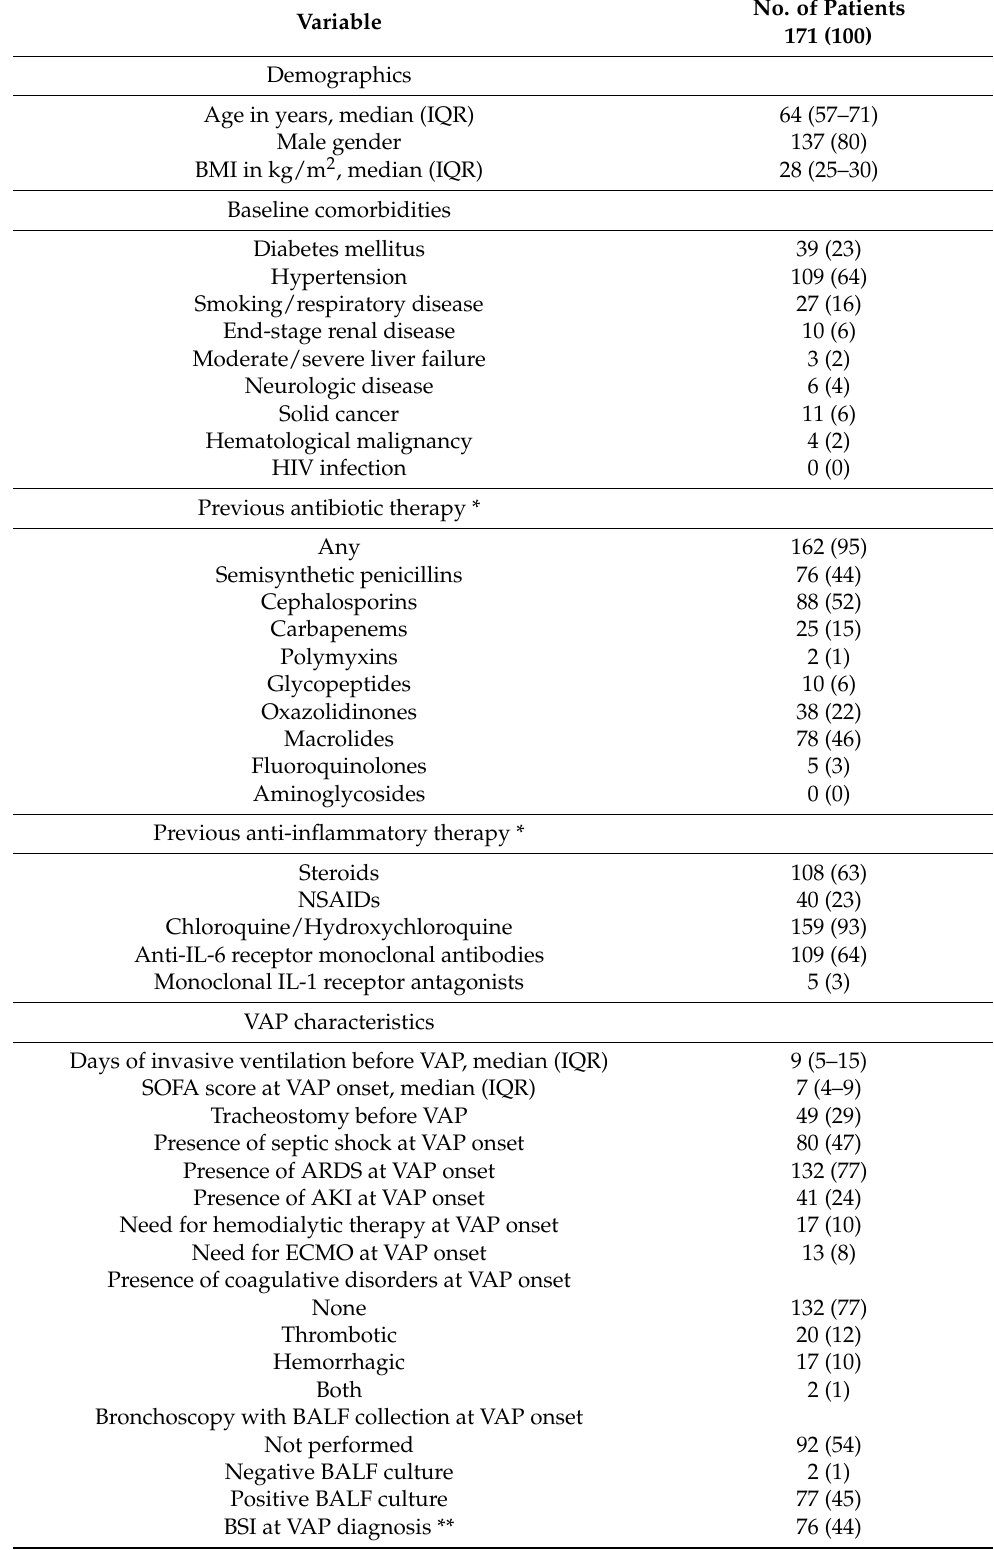
Table 1. Characteristics of 171 critically ill COVID-19 patients who developed ventilator-associated pneumonia